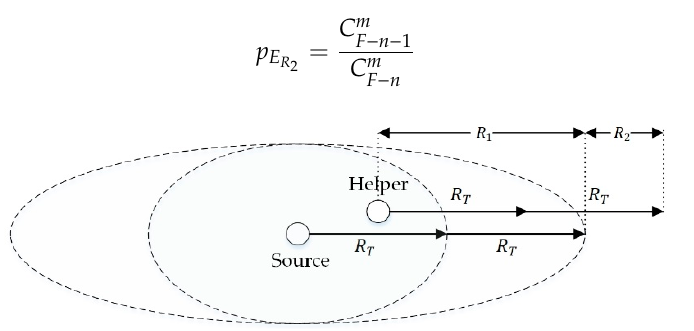
Figure 7. Two-hop regions of the source and the helper.